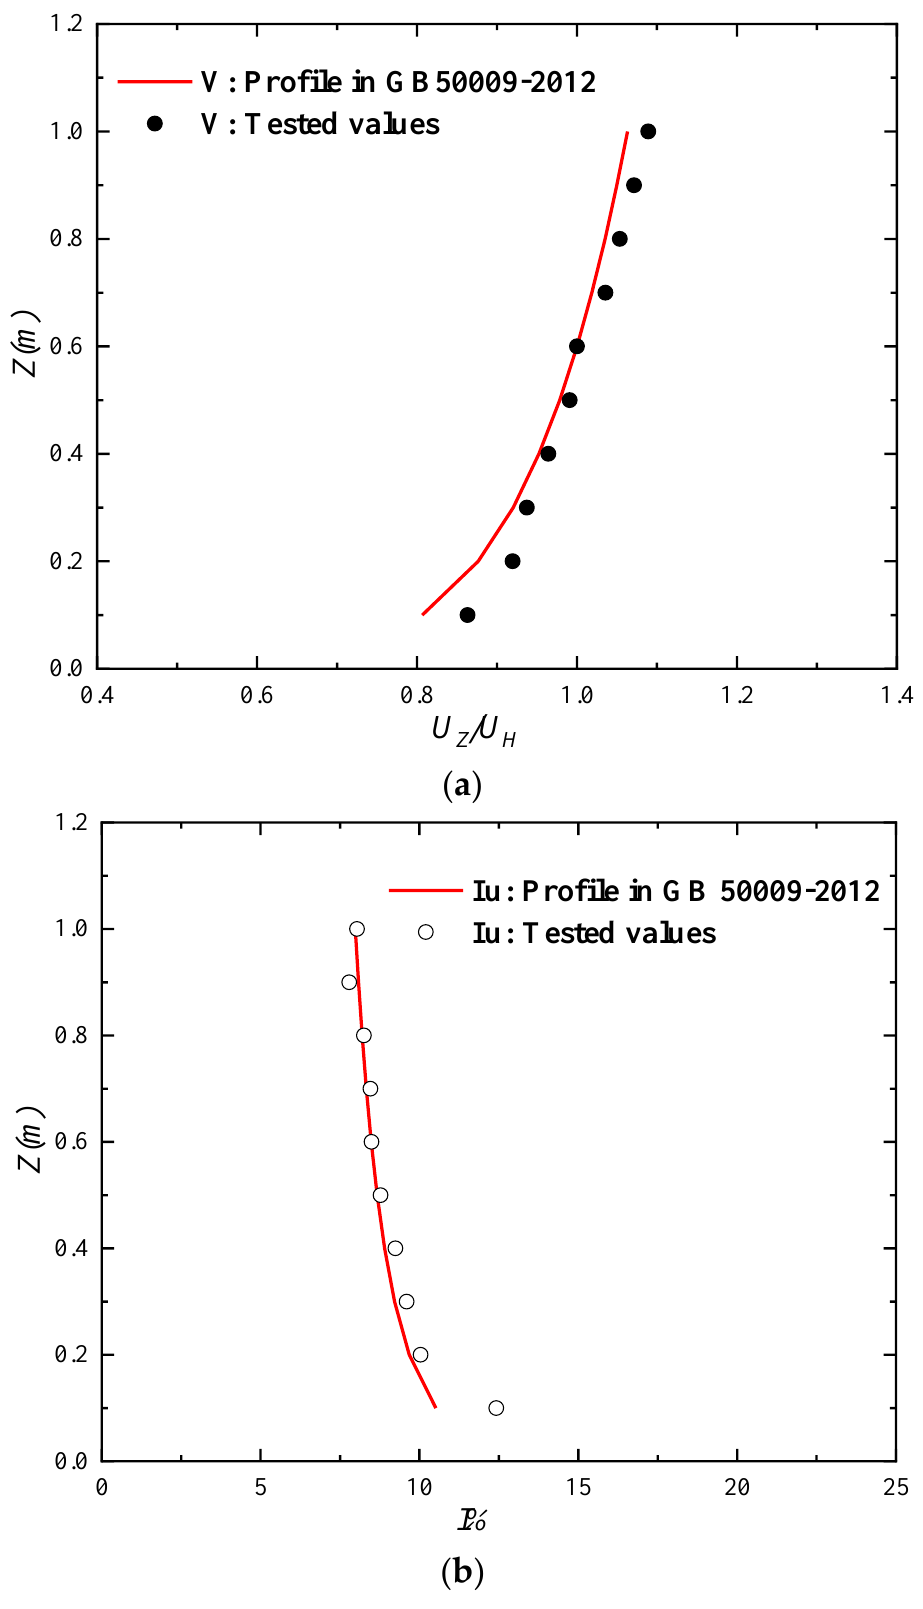
Figure 1. The distribution of mean wind speed and turbulence intensity along height. ( a ) The distri- bution of mean wind speed along height. ( b ) The distribution of turbulence intensity along height.